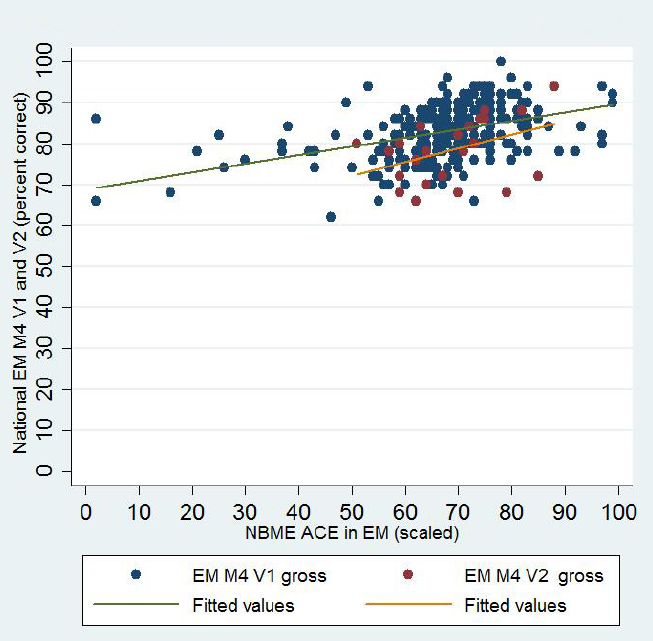
Figure 2. Correlation of NBME EM-ACE and National EM M4 V1 and